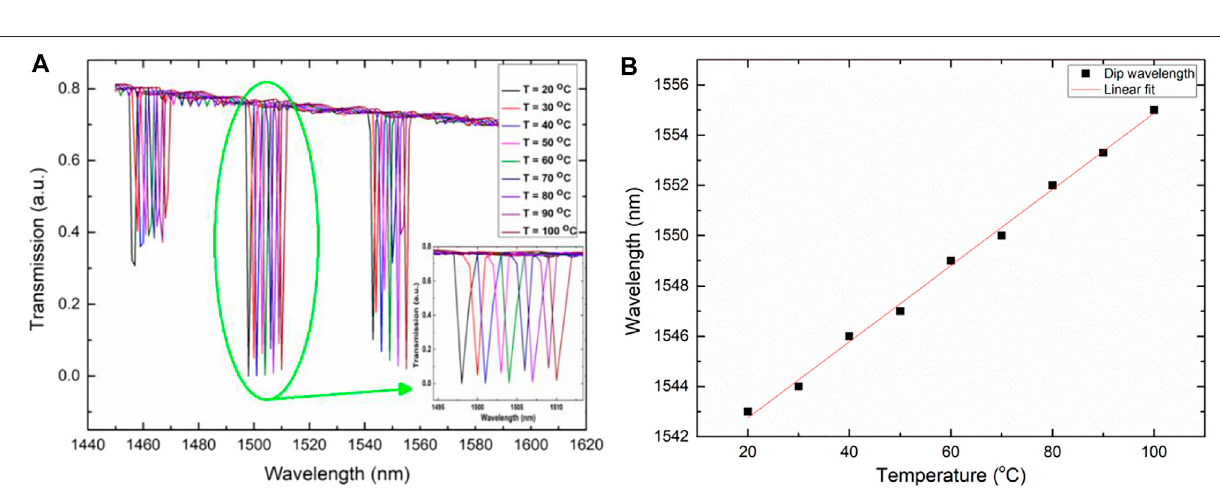
Frontiers in Physics |